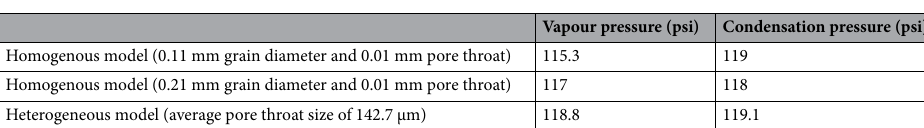
Table 2. Vapour and condensation pressures in homogenous and heterogonous microfluidic chips.